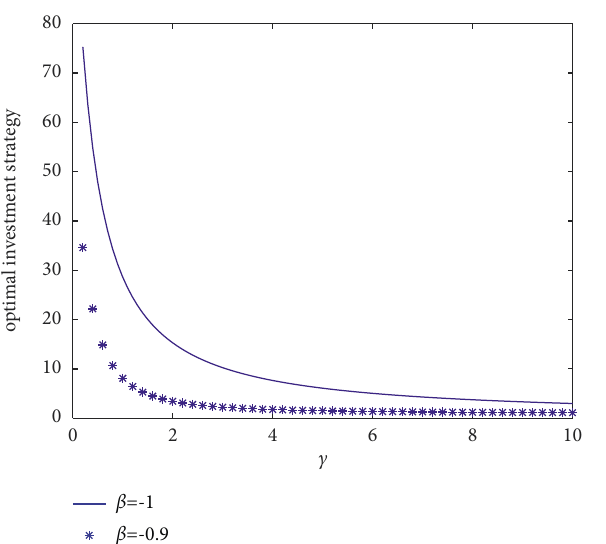
Figure 8: Influence of μ on optimal consumption ratio C ∗ t .